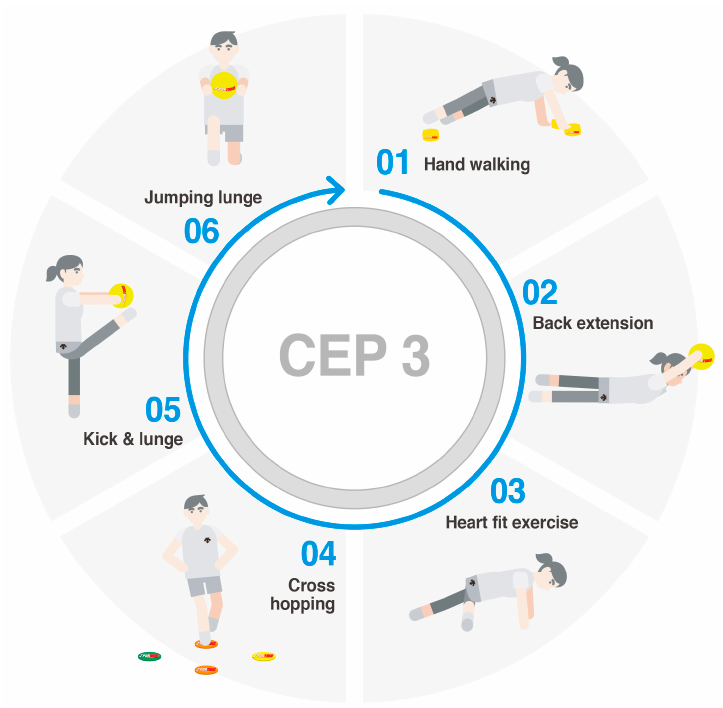
Figure A3. The sequence of motions for circuit exercise program 3: (1) Hand walking, (2) Back extension, (3) Heart fit exercise, (4) Cross hopping, (5) Kick & lunge, (6) Jumping lunge.